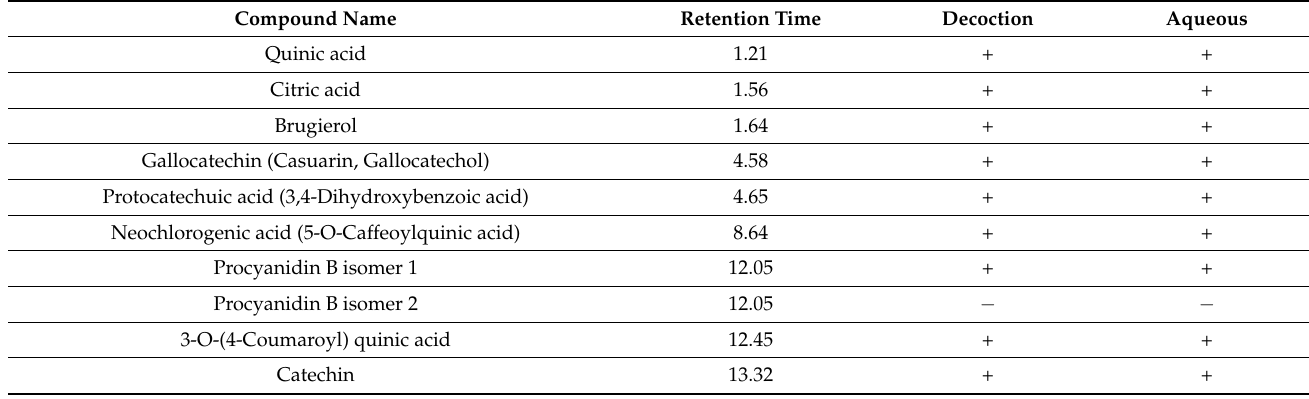
Table 2. Chemical composition of fruit